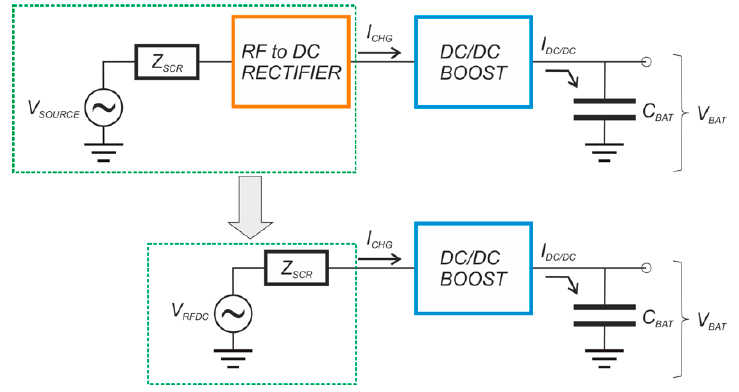
Figure 3. Schematic representation for the source pull optimization.